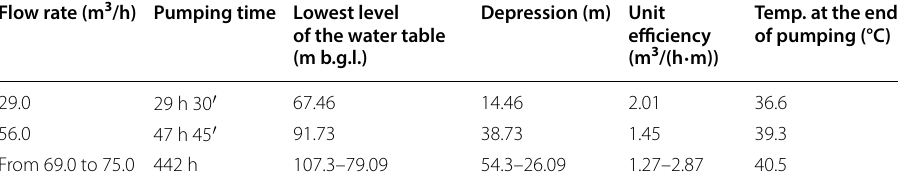
Table 1 Summary of step-drawdown test (measurement pumping) results (Bujakowski (2000) Flow rate (m 3 /h) Pumping time Lowest level of the water table (m